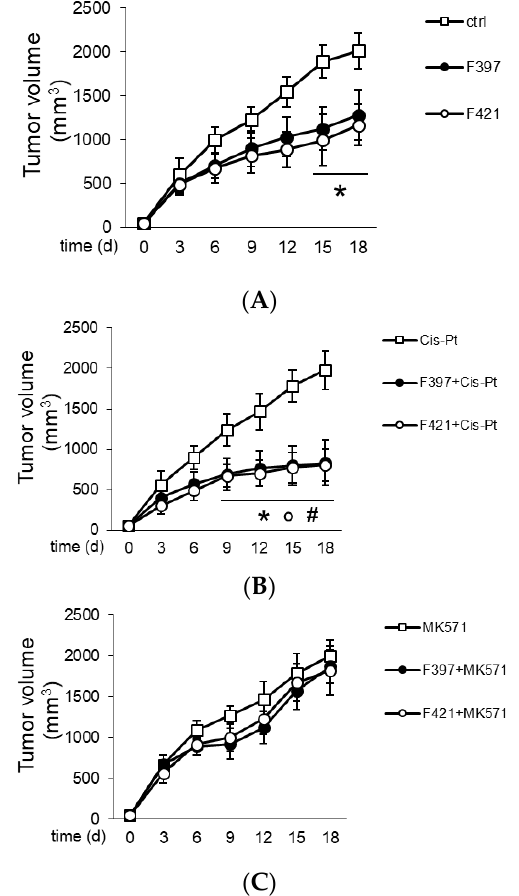
Figure 7. Tumor growth curves: ( A ) Treatment with saline buffer (ctrl), F397 and F421 at 7.5 nM; ( B ) administration of 50 mg/Kg cis-Pt alone and with two target compounds F397 or F421 ; ( C ) administration of 3 mg/Kg MK571, the MRP1 inhibitor, alone and with F397 and F421 .